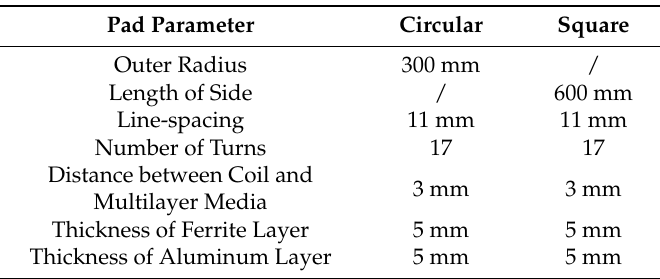
Table 1. Parameters of the spiral